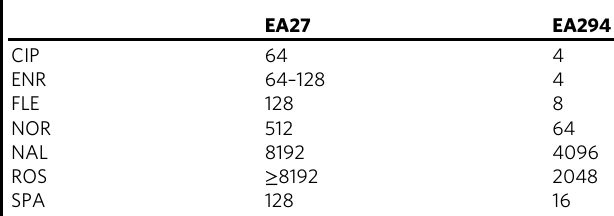
CPTs measured on the multidrug resistant clinical isolate EA27 and the ef fl ux-de fi cient derivative strain EA294. Three independent assays were